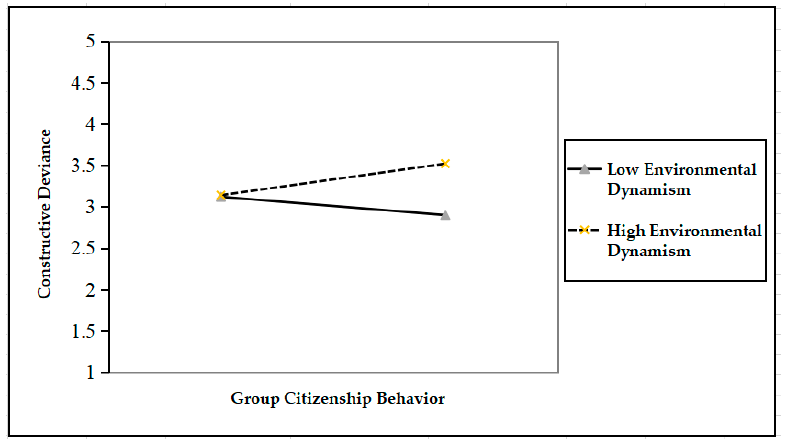
Figure 2. The moderating effect of environmental dynamism on the relationship between group citizenship behavior and moral justification.